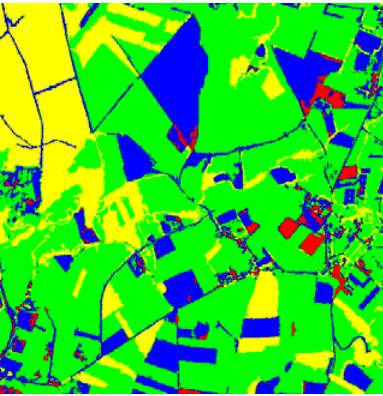
Figure 3. Ground truth image where the labels for the four clusters displayed in Figure 1 have been manually rectified.